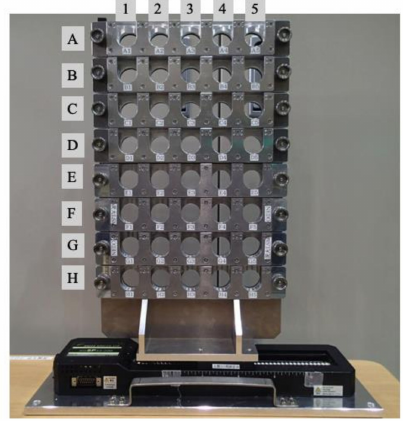
Figure 8. Standard sample changer (40 cuvettes for a round-shape